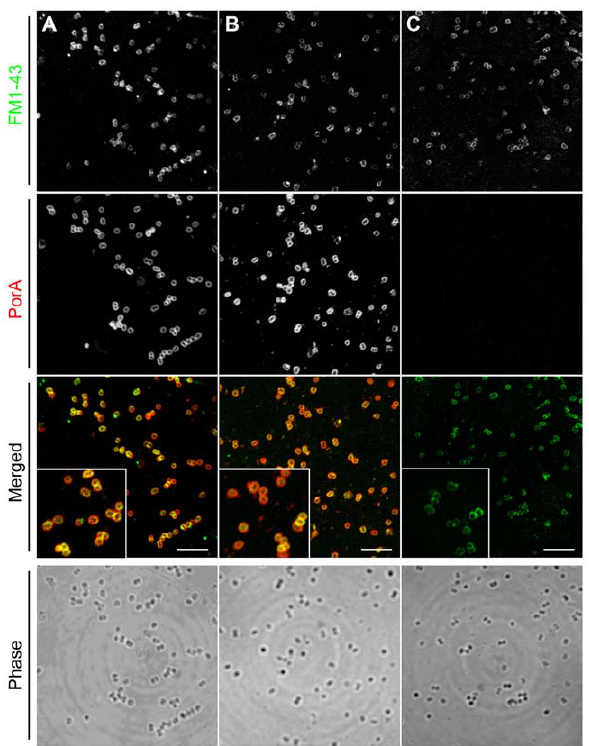
Figure 6. Deletion of loop 4 does not affect insertion of PorA into the meningococcal outer membrane. Immuno-fluorescent images of (A) MC58 wild-type, (B) MC58PorA D 197–210 D pilQ or (C) MC58 D porA D pilQ . Intact cells of N. meningitidis were probed with FM1-43 membrane stain (upper panels) and anti-meningococcal serosubtype P1.7 monoclonal antibody (centre panels). Merged images (lower panels) depict co-localization of FM1-43 (green) and anti- meningococcal serosubtype P1.7 monoclonal antibody (red), in yellow. Phase images (bottom panels) verify the presence of immuno-targets. Insets shown are at 2.5 6 field magnification. Scale bar: 5 m